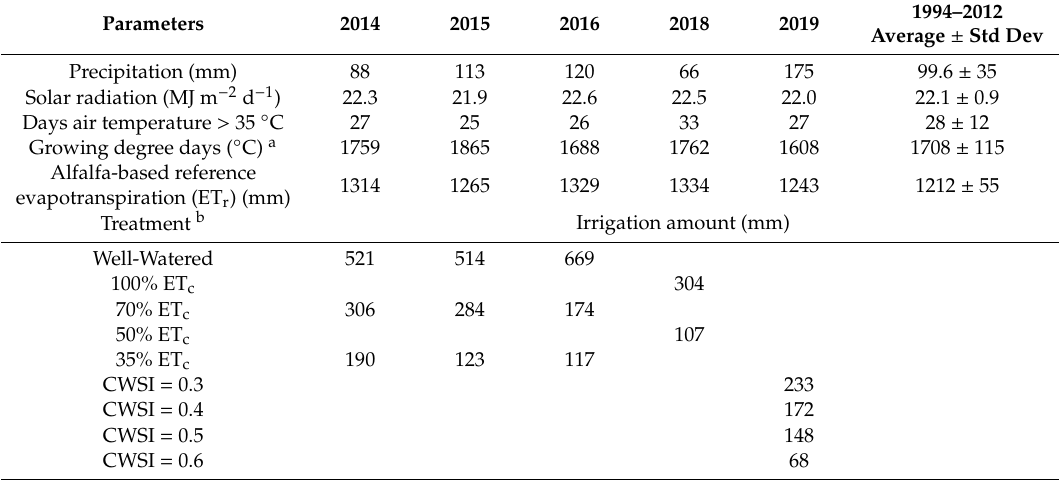
Table 1. Weather and climate data from 1 Apr through 31 Oct for the field trial site in Parma, ID, and average irrigation amount supplied between fruit set and harvest to each treatment in each study year. Weather data were collected at the Parma (PMAI) weather station located 3 km from the field trial site ((www.usbr.gov / pn / agrimet / ), latitude 43 ◦ 48 (cid:48) 00”, longitude 116 ◦ 56 (cid:48) 00”, elevation 702